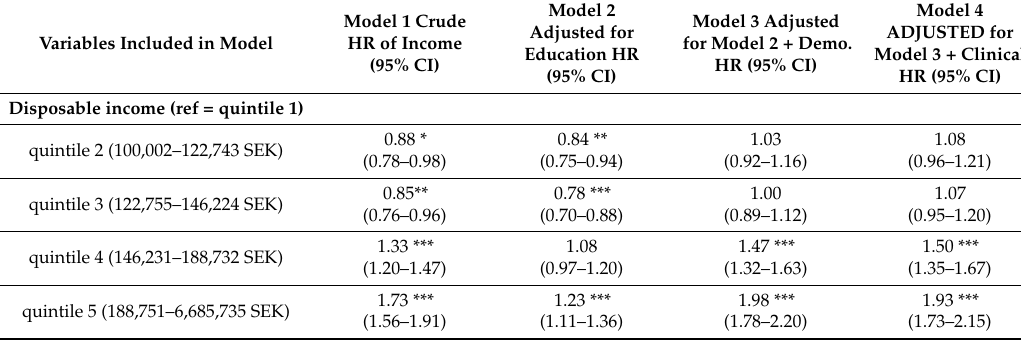
Table 6. Sensitive analyses of the association between income and access to non-pre-emptive transplantation by Cox proportional hazards model ( n =